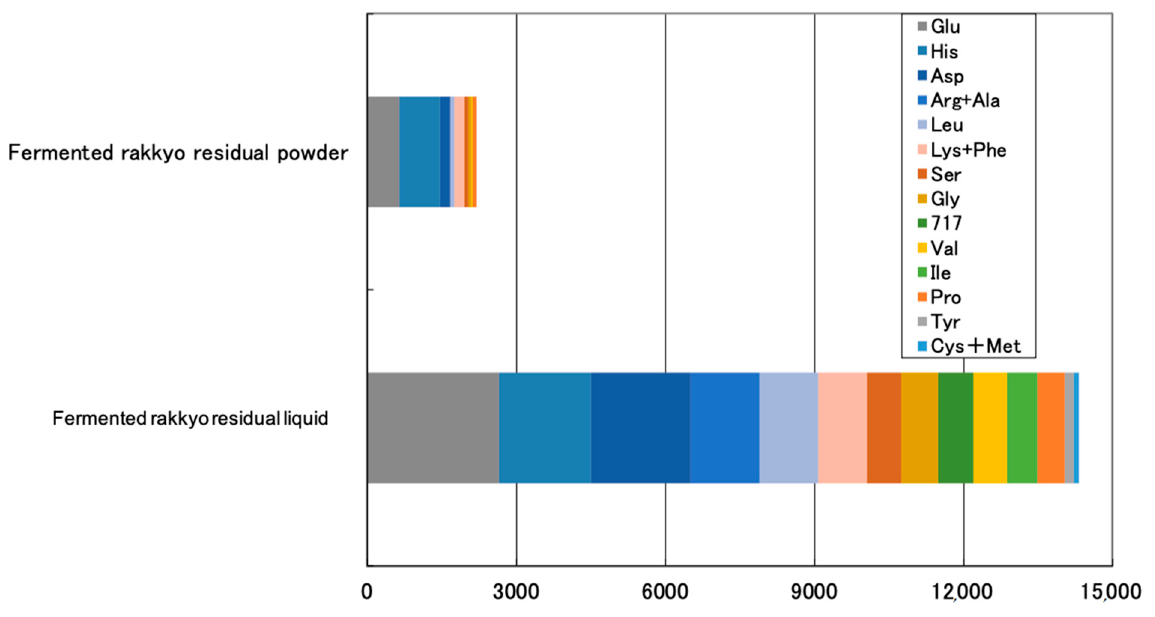
Figure 2. Amino acid components of fermented rakkyo residual liquid (pickled juice) and residual powder solution (mg/100 g).